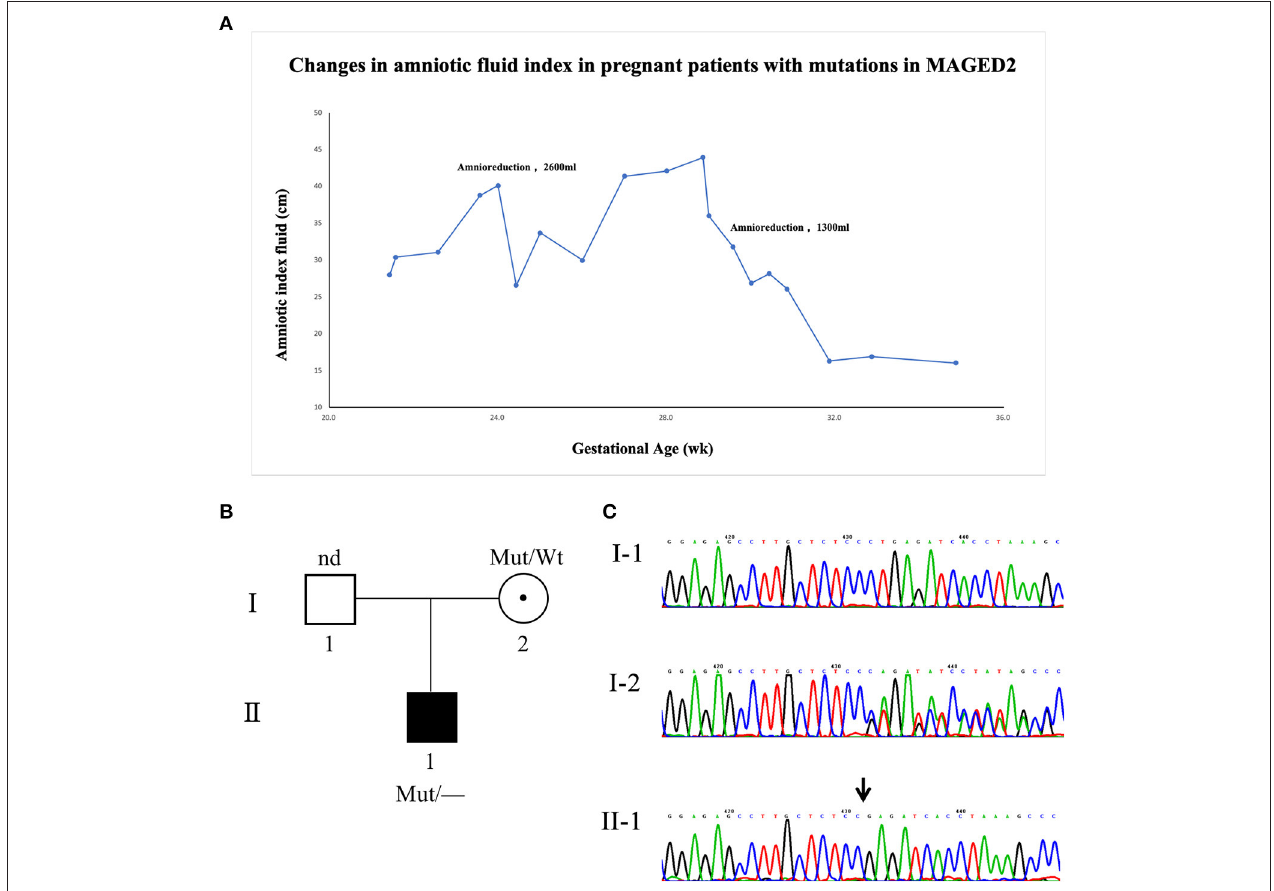
FIGURE 1 | Clinical and genetic characteristics of the family with the MAGED2 mutation. (A) The changes in the amniotic fluid index during pregnancy for the patient with an MAGED2 mutation during pregnancy. (B) A pedigree diagram of the family. (C) Sanger analysis showed c.733_734delCT (p. Leu245GlufsTer4) of the MAGED2 (NM_177433.1) variant in the fetus; his mother carried the variant in the heterozygous state.